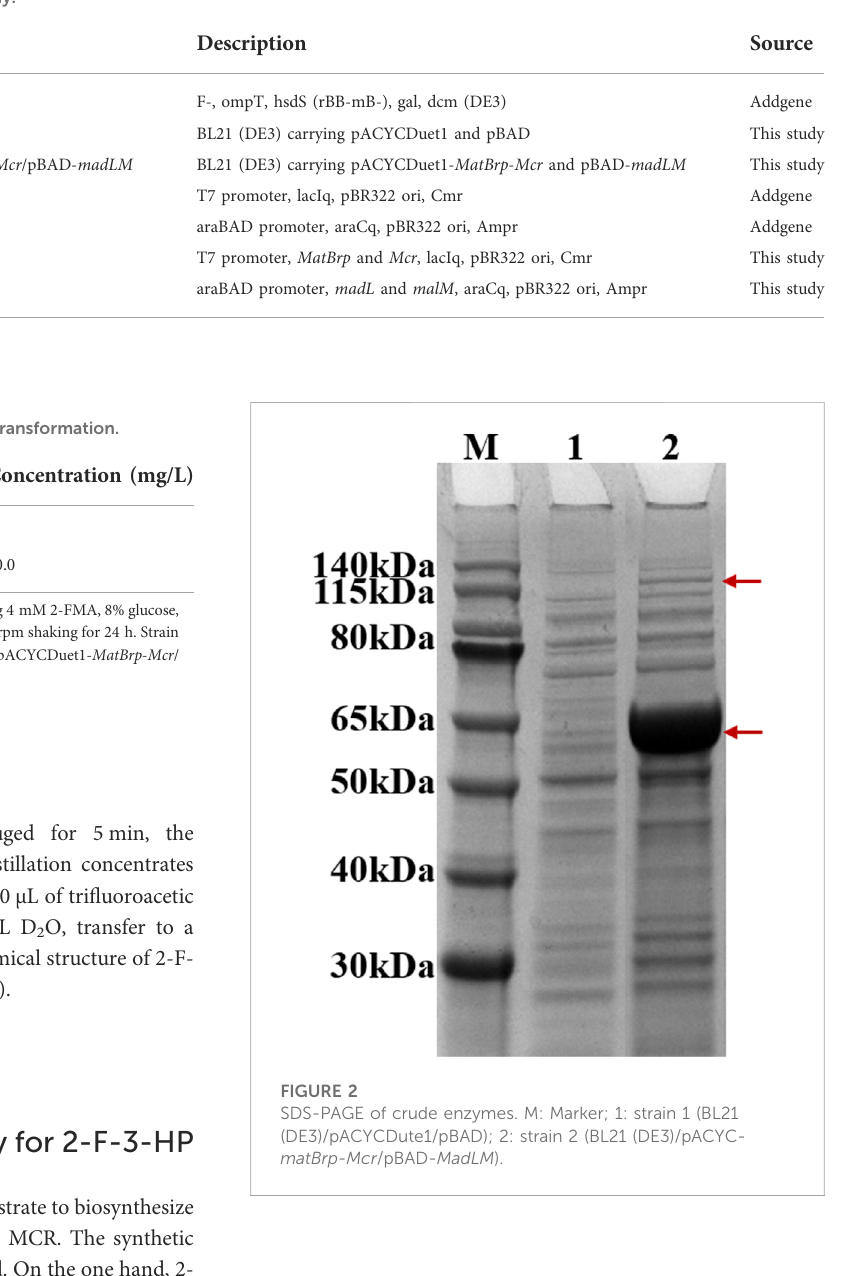
TABLE 1 Strains and plasmids used in this study.